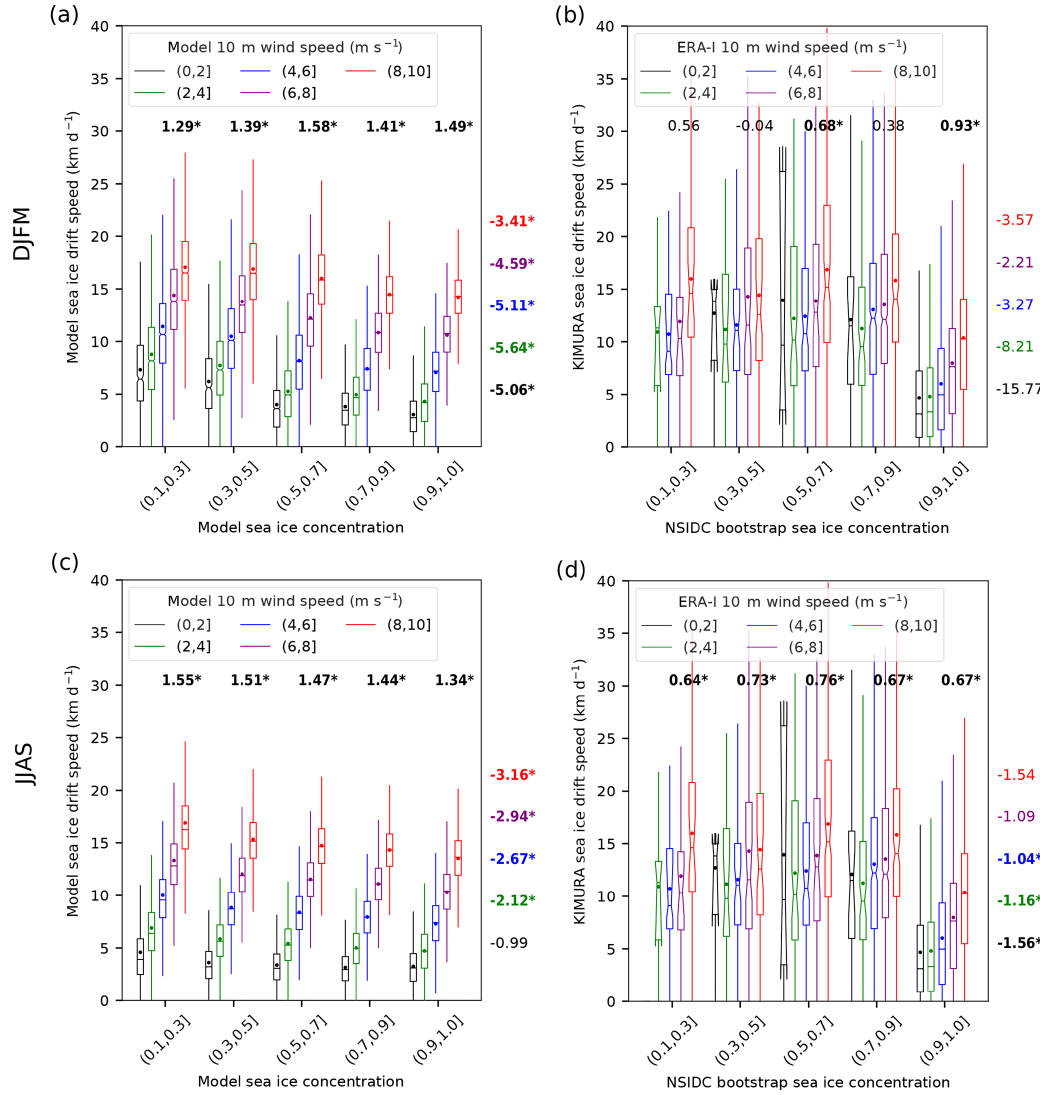
Figure 4. Box–whisker plots of the relationship between sea ice drift speed and sea ice concentration for different near-surface wind speed classes (different colors) for the 2003–2014 (a) winter (DJFM) and (c) summer (JJAS) in the model (HIRHAM–NAOSIM 2.0). Panels (b) and (d) are the same as (a) and (c) , respectively, but based on the observation/reanalysis data. For the model, all 10 ensemble members are included. The plot is based on daily data and on all grid points within the study domain indicated in Fig. 1. The horizontal bar represents the median, the notch represents the 95% confidence interval of the median, the dot represents the mean, the top and bottom of the box represent the 75th and 25th percentiles, and the upper/lower whiskers represent the maximum/minimum value within 1.5 times the interquartile range (IQR) to 75th/25th percentiles. The numbers above the boxplots represent the slopes of near-surface wind and sea ice drift speed fit lines (unit: kmd − 1 per 1ms − 1 wind speed change; font colors as for the wind speed classes). The numbers right of the boxplots represent the slopes of sea ice concentration and sea ice drift speed fit lines (unit: kmd − 1 per 10% sea ice concentration change). A bold and asterisked number indicates that the slope of the fit line is significant at the 95% level. In the labels of different sea ice concentration and 10m wind speed classes, “(” means exclusive and “]” means